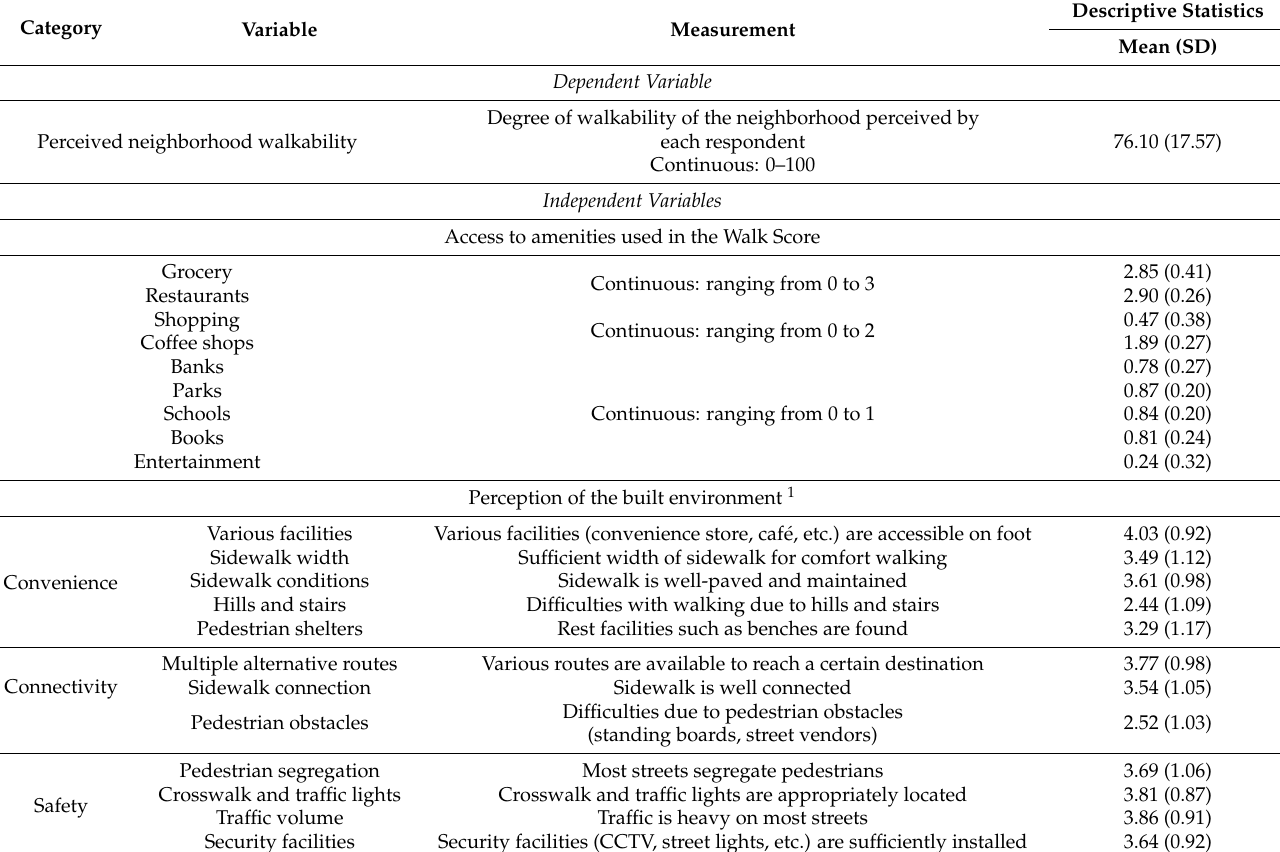
Table 2. Measurement and descriptive statistics of survey